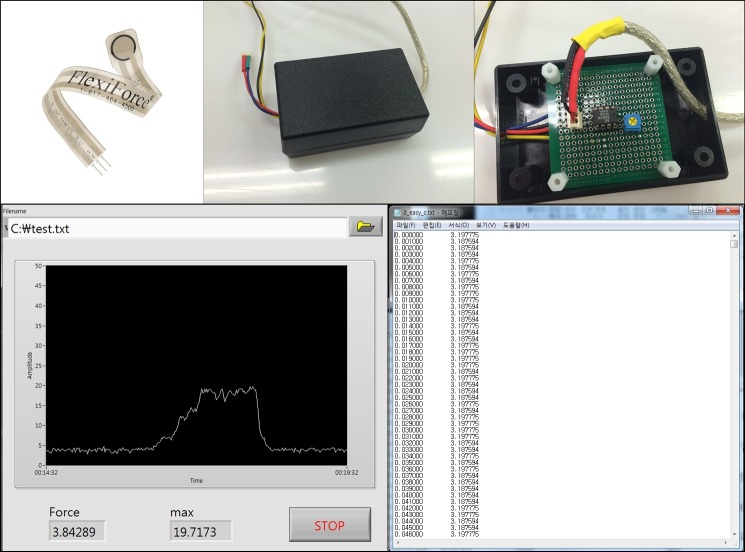
Peak force measurement during intubation using a FlexiForce standard load/force sensor and LabView programming.